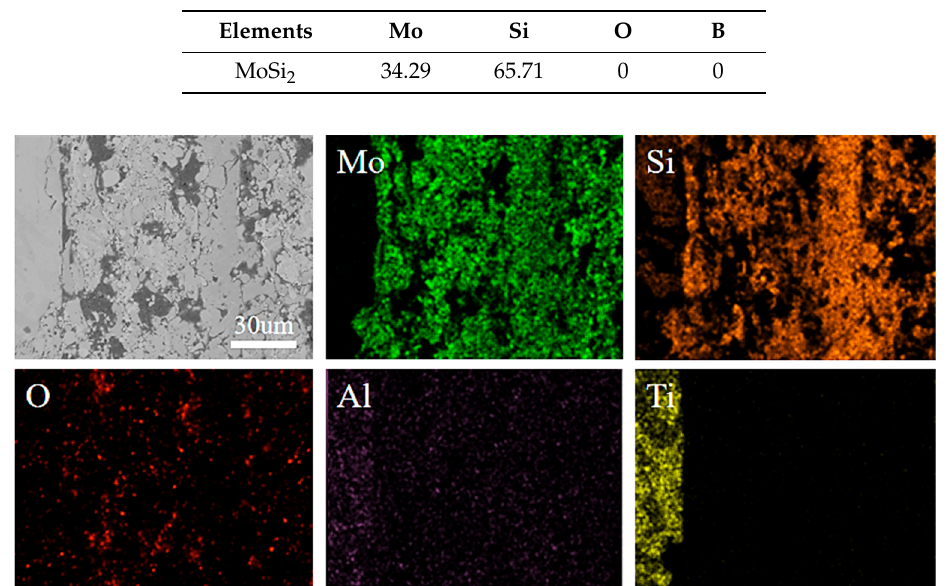
Figure 4. Elements mapping for the MoSi 2 -ZrB 2 coating of the mz45 sample. Table 2. The EDS results of constituent phase of mz45 sample (at.%).